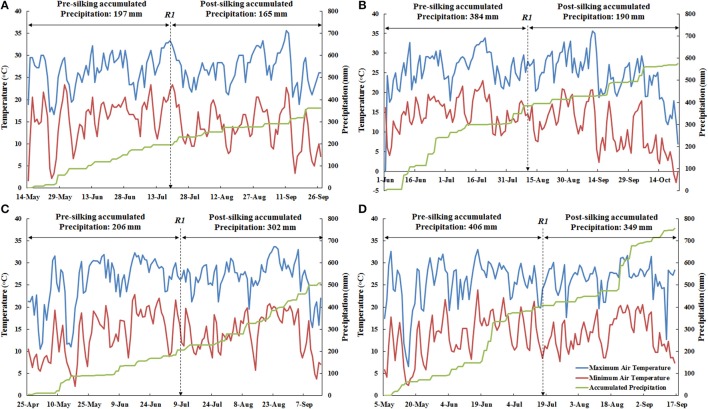
The weather conditions for the two sites in both 2013 and 2014, including maximum air temperature (°C, blue line), minimum air temperature (°C, red line), and accumulated precipitation (mm, green line). For each environment, maximum air temperature and minimum air temperature shared the primary y-axis (left) and accumulated precipitation used secondary y-axis (right). Date for actual 50% silking (R1) was marked for each environment by a dashed arrow. The amount of pre-silking and post-silking accumulated precipitation are also marked in each environment. (A), Represents ACRE, 2013; (B), Represents PPAC, 2013; (C), Represents ACRE, 2014; and (D), Represents PPAC, 2014.